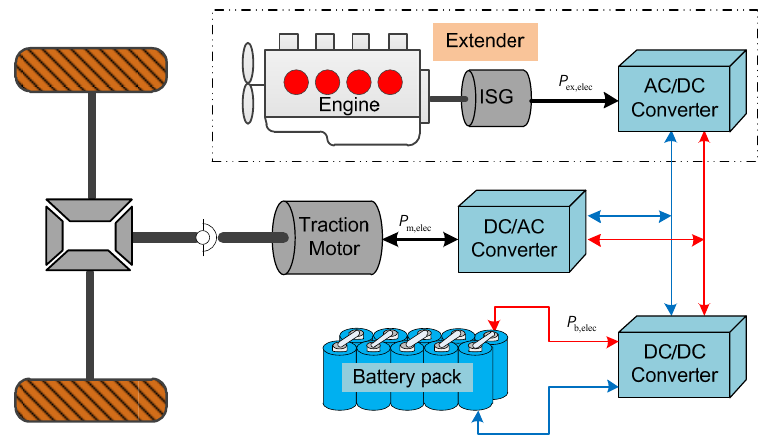
Figure 1. Extended range electric vehicle (EREV) powertrain configuration and power